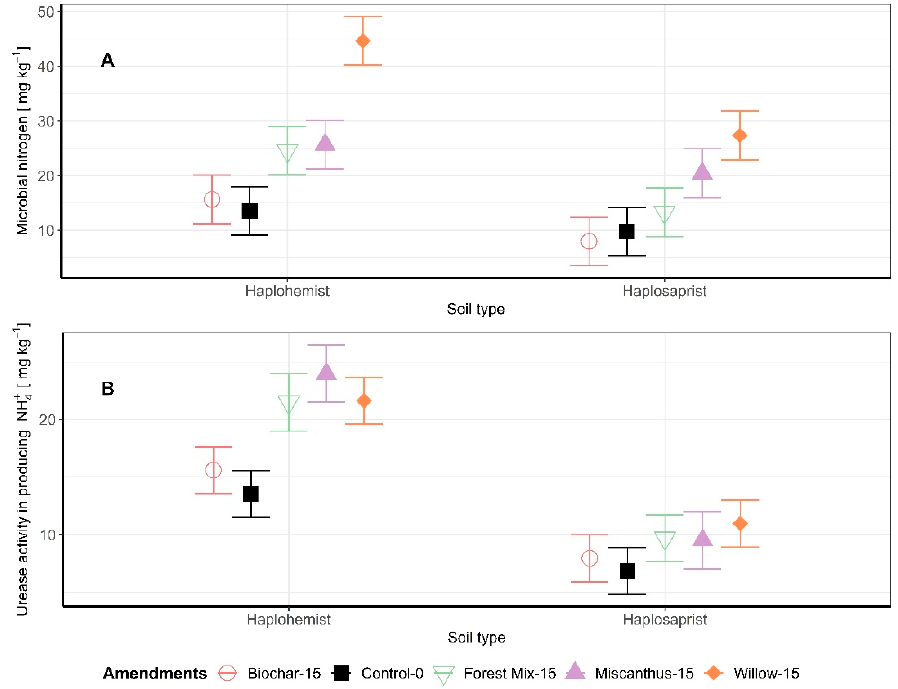
Figure 3. ( A ) Microbial biomass N; ( B ) Urease activity as a function of soil type and amendment. A significant linear relationship was observed between cumulative leached TSN, minN, SON, and the microbial biomass N content (Figure 4).